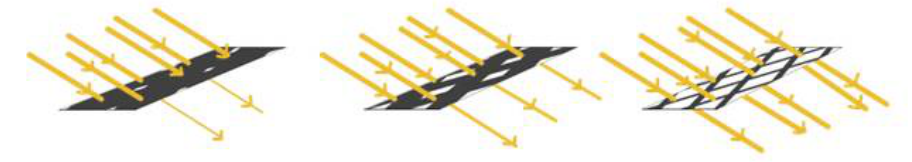
Fig.2 Control over the amount of light depending on pattern